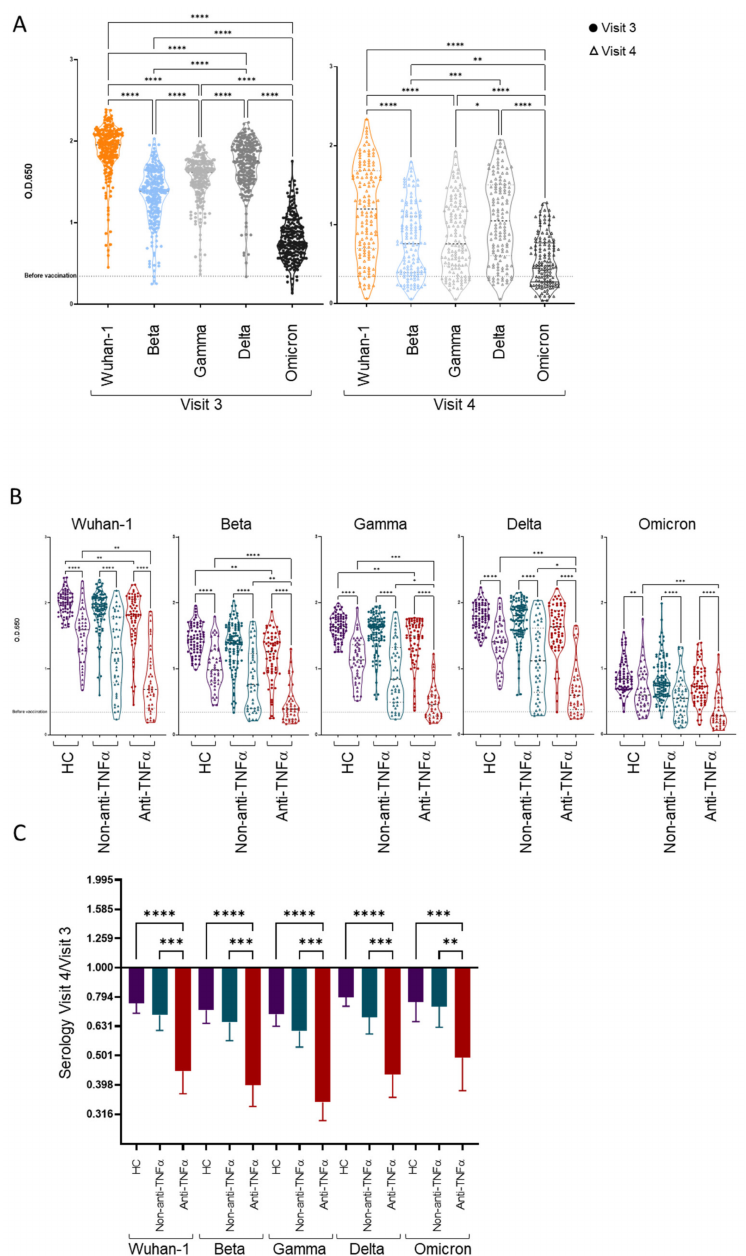
Figure 6. Patients with IBD treated with anti-TNF α had reduced cross-reactivity. ( A ) Ability of vaccinee sera to bind SARS-CoV-2 RBD from Wuhan-1 strain and variants of concern (VOCs)—beta, gamma, delta and omicron (Wuhan-1 in orange, beta in light blue, gamma in light grey, delta in dark grey and omicron in black)—as measured with ELISA, at two time points: 1 month post vaccination (visit 3, filled circles) and 6 month post vaccination (visit 4, open triangles). ( B ) Ability of vaccinee sera to bind SARS-CoV-2 RBD from Wuhan-1 strain and VOCs, separated to healthy controls (HCs, shown in purple), patients with IBD receiving non-TNF α treatment (non-anti-TNF α , shown in blue) and patients with IBD receiving anti-TNF α treatment (anti-TNF α , shown in red). Dotted line indicating mean O.D. value from 5 sera samples before vaccination. ( C ) Bar plot indicates mean and 95% CIs of fold change in sera binding ability over time for HCs, non-anti-TNF α and anti-TNF α groups, stratified by variant. Values were calculated using ELISA O.D. results, by dividing V4/V3 value, only for vaccinees with samples for both time points. ( A – C ) Statistical analysis was carried out using independent sample Kruskal–Wallis test. *— p < 0.0332, **— p < 0.0021, ***— p < 0.0002, ****— p <